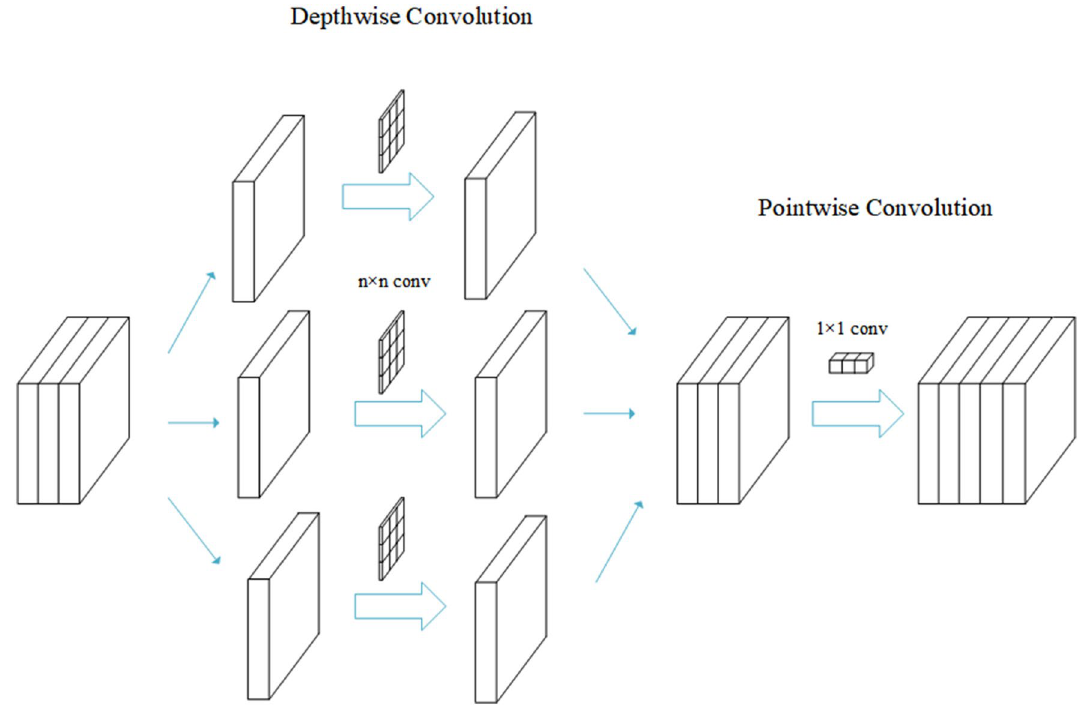
Figure 3. Separable convolution